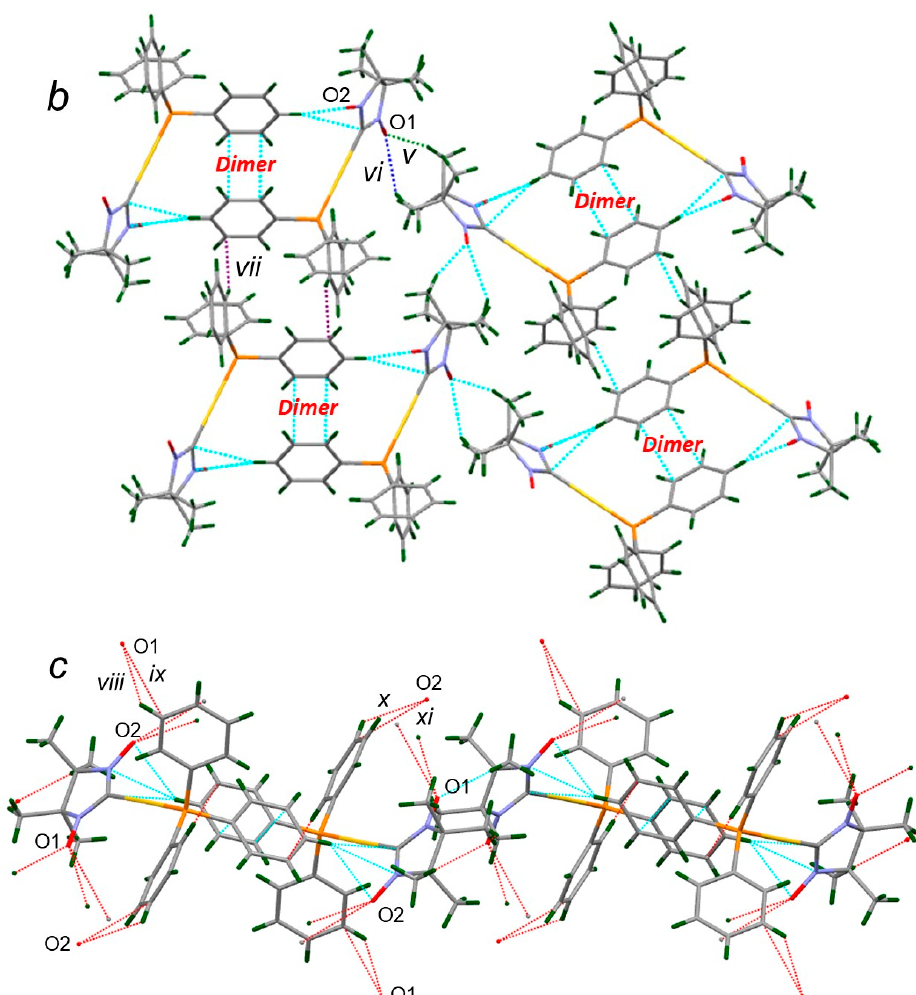
Figure 4. Short intermolecular contacts and interatomic distances in crystals of NN-Au-PPh 3 [4]: dimer formation ( a ), binding of dimers info a layer ( b ), and binding the layers into a 3D framework (( c ) red dashed lines). Crystals 2020 , 10 , x FOR PEER REVIEW